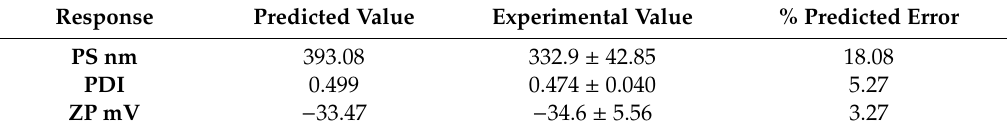
Table 8. Summary of results for the NCC produced using optimum formulation parameters.